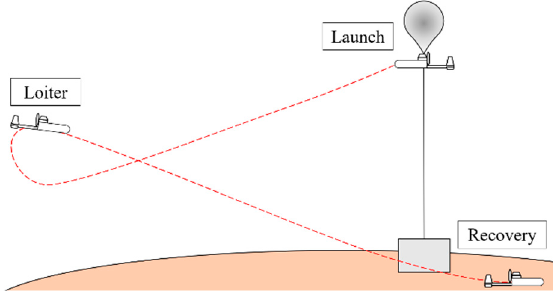
Figure 15. Balloon launch concept for a UAV.